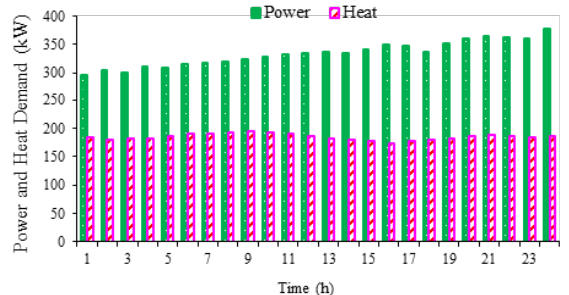
Fig. 2. Power and heat demand in the microgrid system.